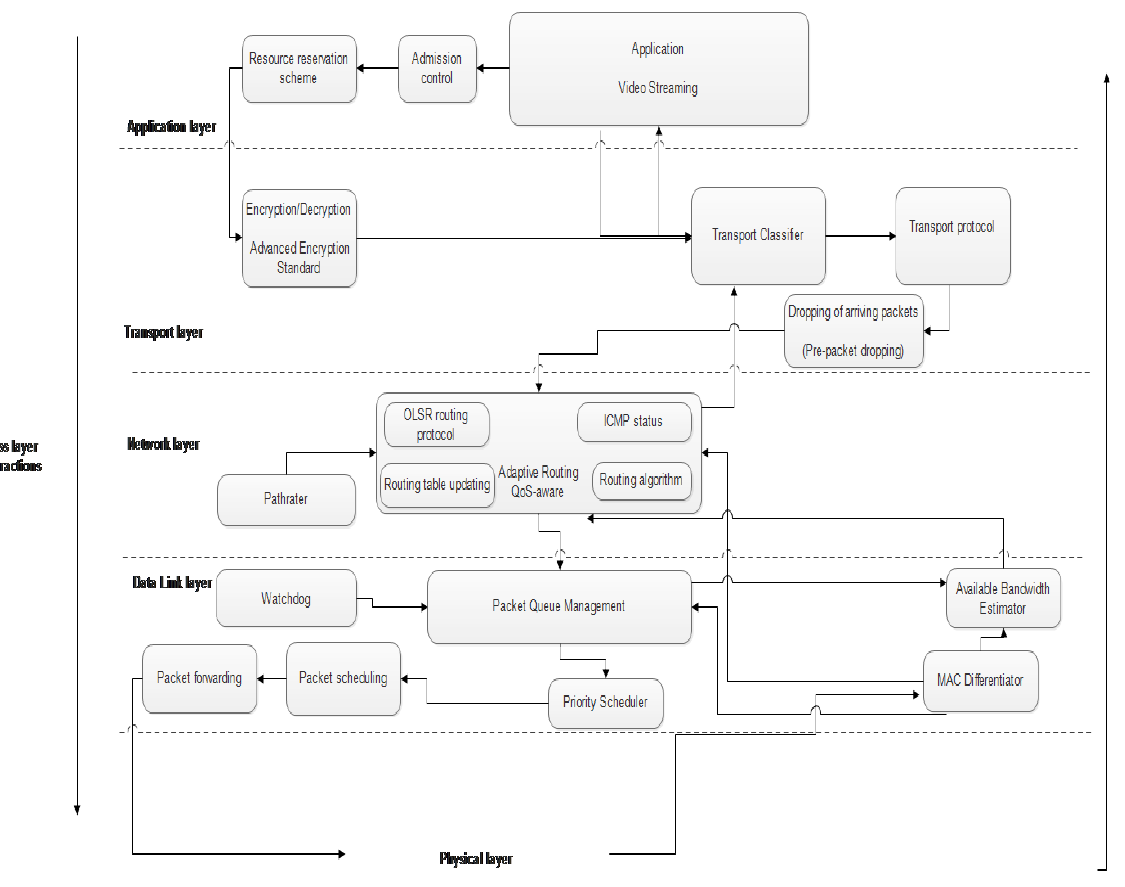
Figure 2. QoS-aware security framework [19].